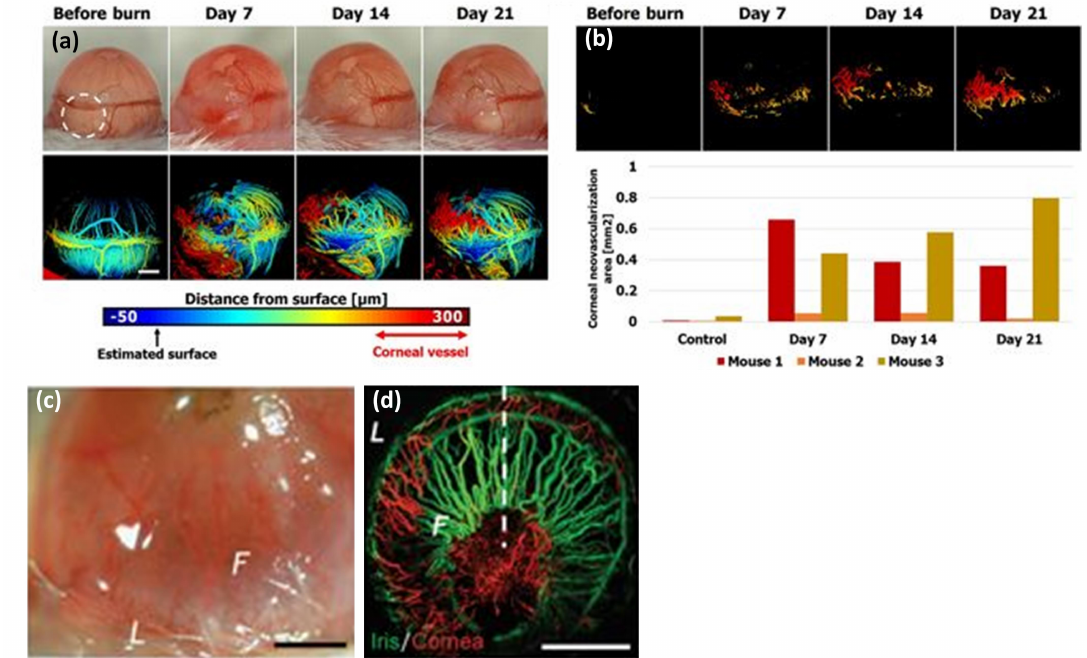
Figure 7. PAOM of corneal neovascularization. ( a ) Surface-based depth encoded PAM images of corneal before and after alkali burn-induced corneal neovascularization at various times. ( b ) Segmented PAM image of supra-surface vessels and quantified corneal neovascularization area [51], ( c ) bright field microscopy image of the eye, and ( d ) PAM distinguishes between the iris (green) and corneal (red) vasculatures, due to their different depths. The green arrow points toward iris vessels; the red arrow points toward corneal neovascularization in the Z-slice. F: front, and L: limbus [85]. Adapted with permission from ref.